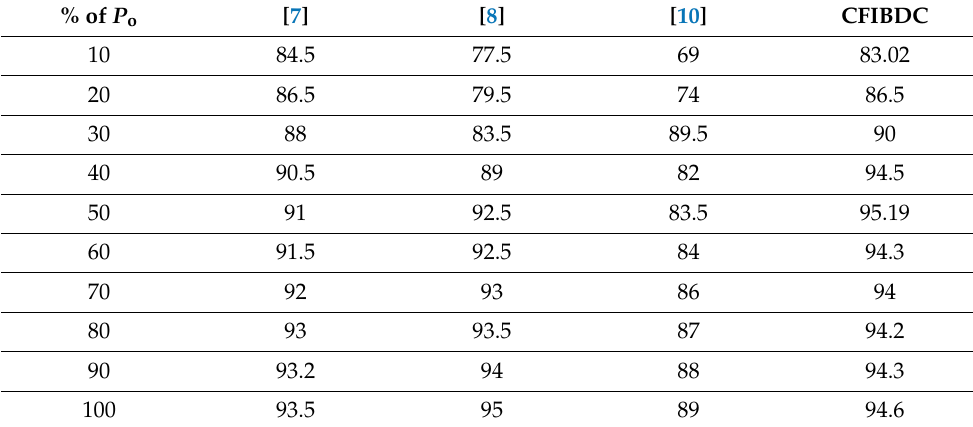
Table 4. Comparison of efficiencies of different topologies with proposed current-fed isolated bidirec- tional DC-DC converter (CFIBDC) (Percentage of output power (% of P o ) Vs. Efficiency of Topologies given with reference number).